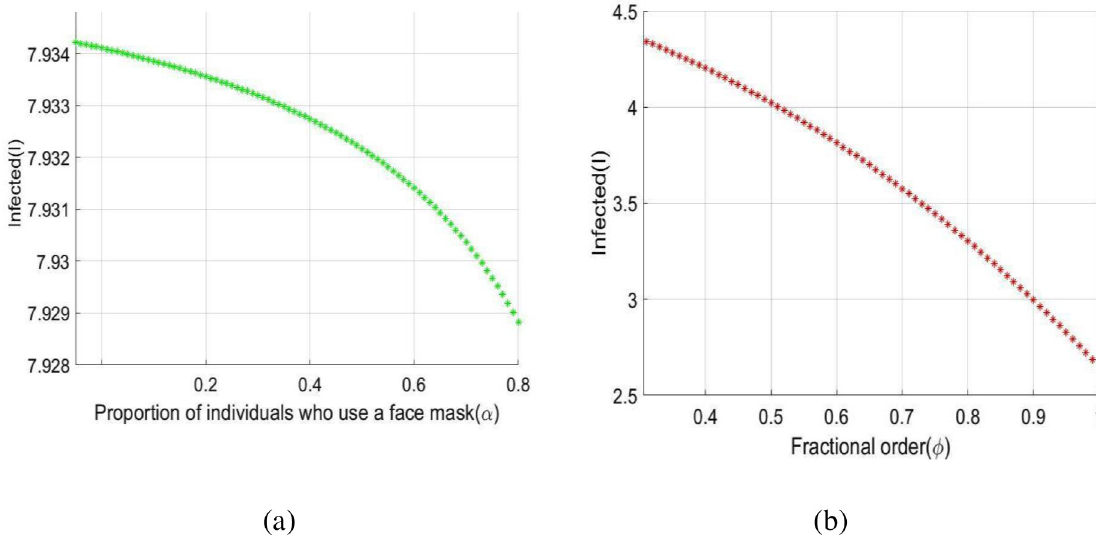
Fig 5. Dynamics of I ( t ) under α and ϕ